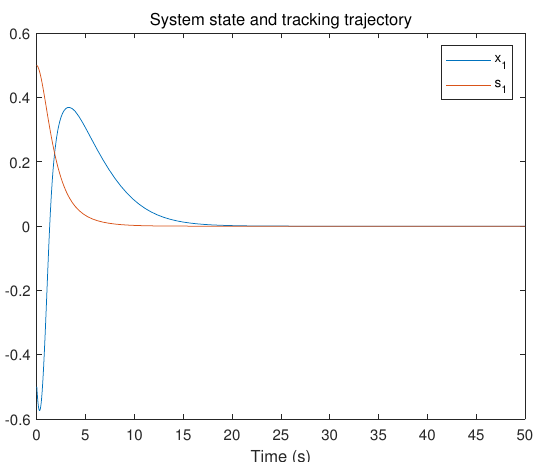
Figure 9. System state x 1 and its tracking trajectory when η 1 = − 0.2 and η 2 = 0.2.